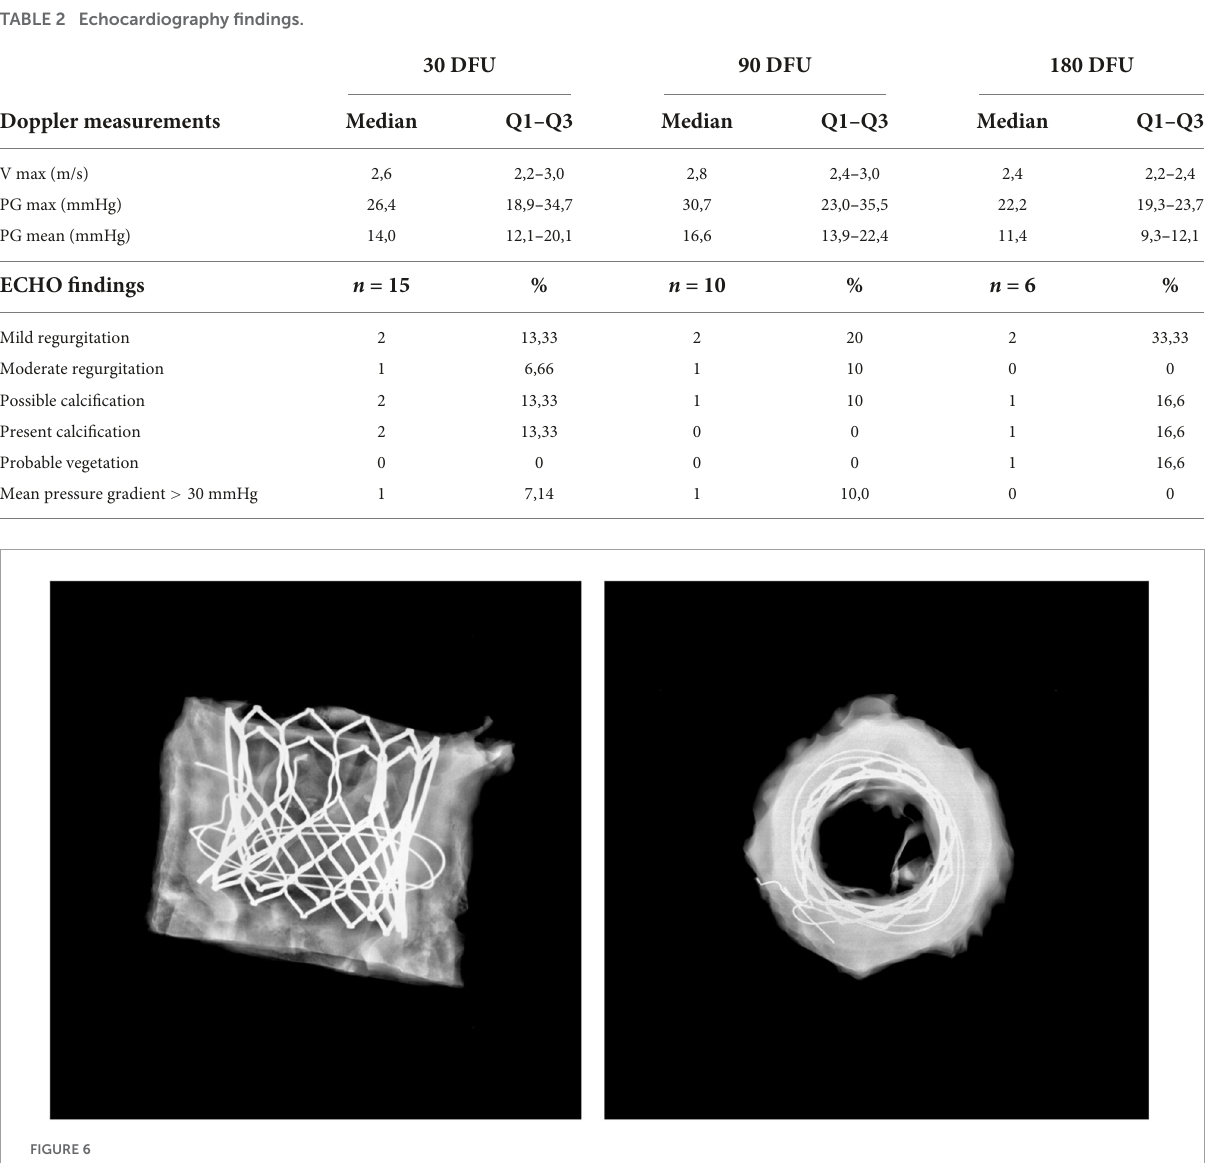
FIGURE6 X-ray image. No deformations or damages in stent